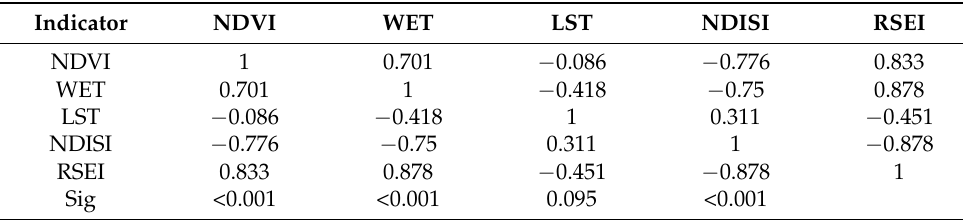
Table 1. Correlation coefficient matrix of indices over the period 1996–2021.